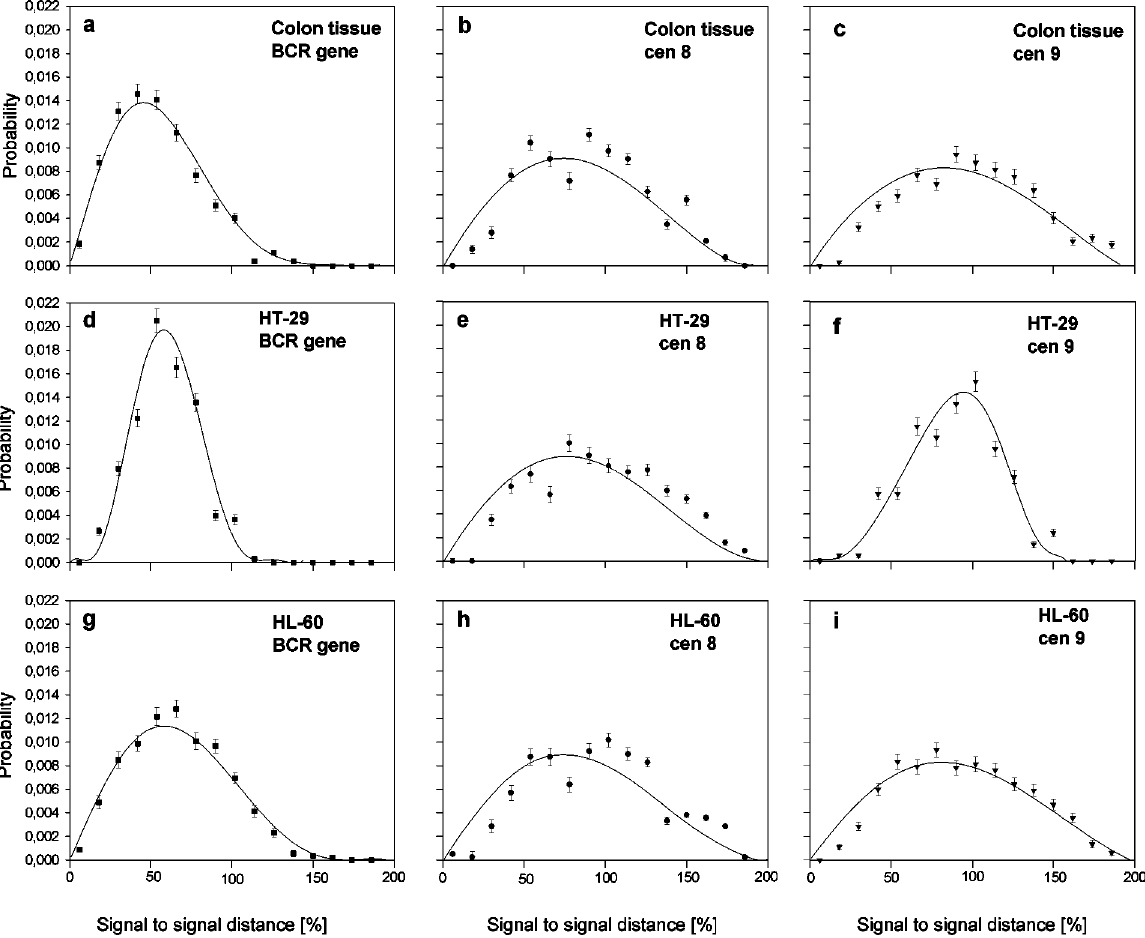
Fig. 4. Distributions of the signal to signal distances determined for the homologous BCR genes (a, d, g), chromosome 8 (b, e, h) and 9 (c, f, i) centromeres in nuclei of cells separated from colon tissue of human donor (a, b, c), HT-29 (d, e, f) and HL-60 (g, h, i) cells. Experimental results are compared with theoretical functions (full curves) obtained by Monte-Carlo simulations (see Materials and methods). The number of investigated cells was 800–1000 for each